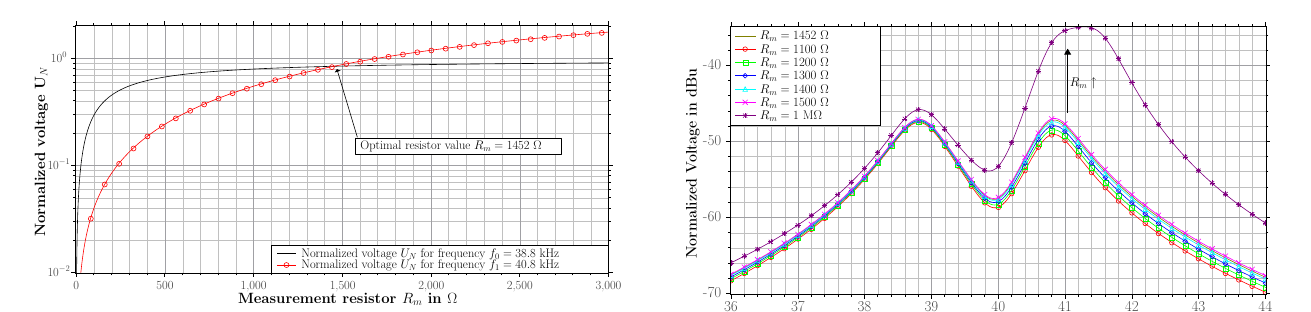
Figure 6. Graph of the simulated frequency response for matched ( R m = 1452 (cid:127) ) and unmatched ( R m = 1 × 10 6 (cid:127) ) piezoelectric re- ceivers. The amplitude difference between the frequencies f 0 and f 1 for the unmatched receiver is about 10dB.